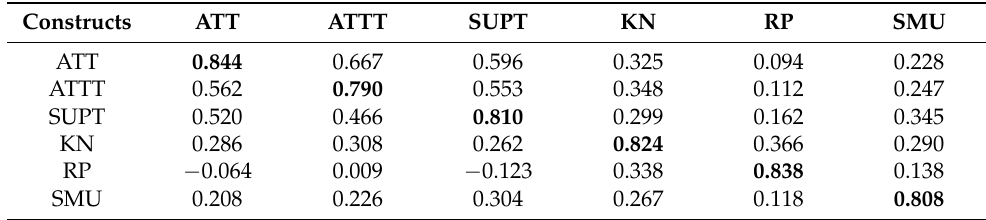
Table 4. Discriminant